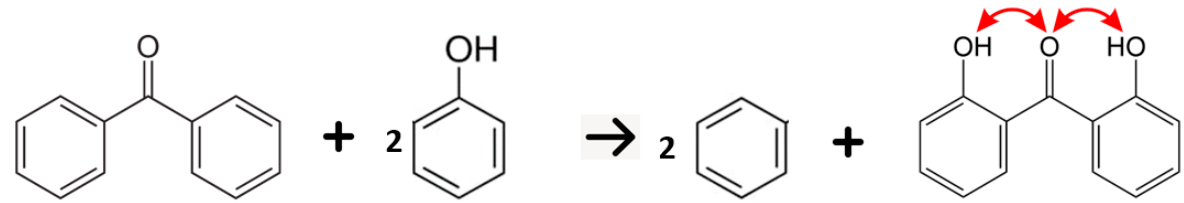
Figure 12. Determination of the intra-molecular hydrogen bonding strength in 2-hydroxy-benzophenone using the “ well-balanced reaction ” method. The reaction enthalpy ∆ r H o m(WBR) = − 40.8 kJ · mol − 1 (see